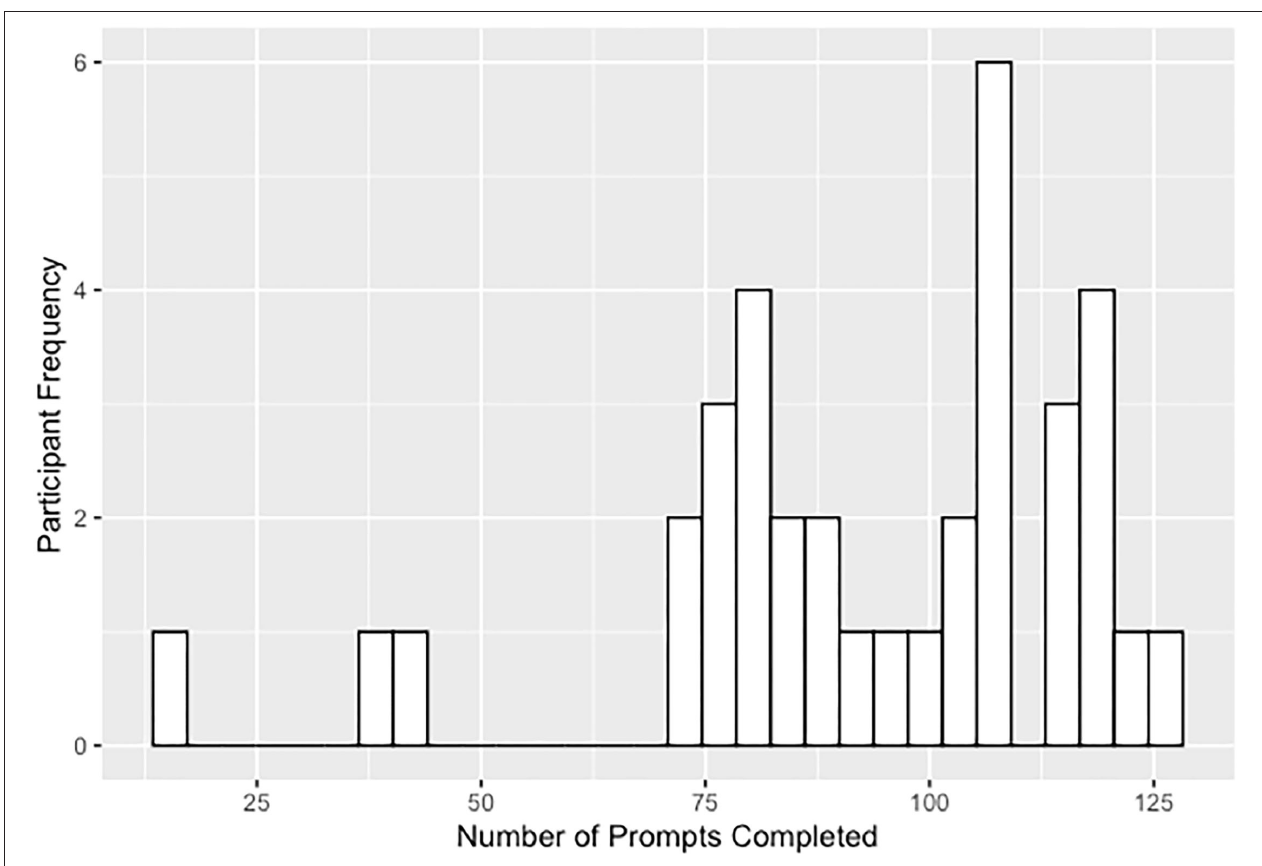
FIGURE 1 | Distribution of answered prompts for the 3-week ESM study including the 3 participants excluded due to low number of answered